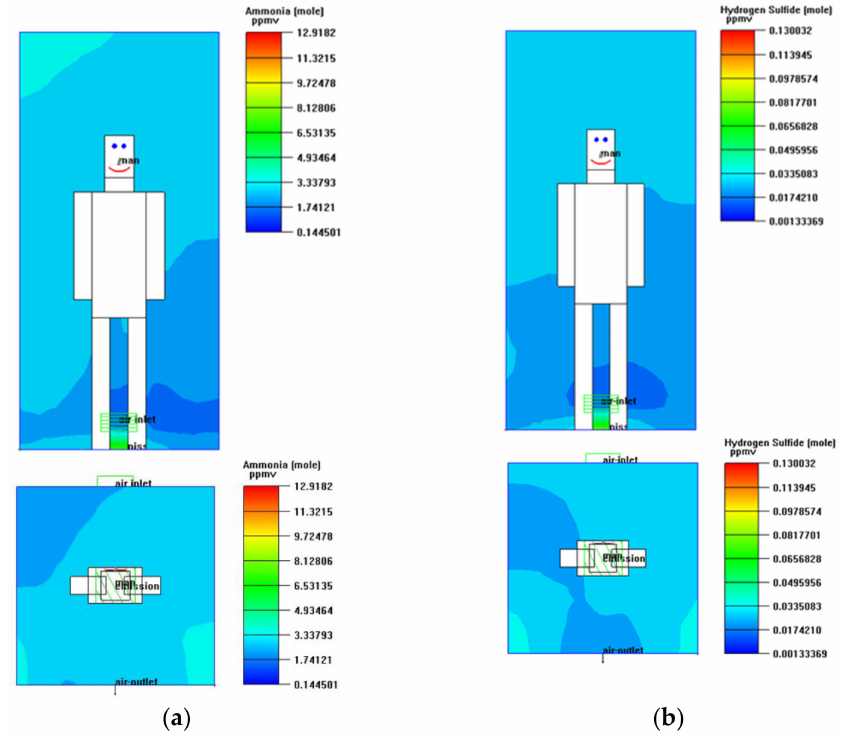
Figure 8. Concentration distribution of ( a ) NH 3 and ( b ) H 2 S in the